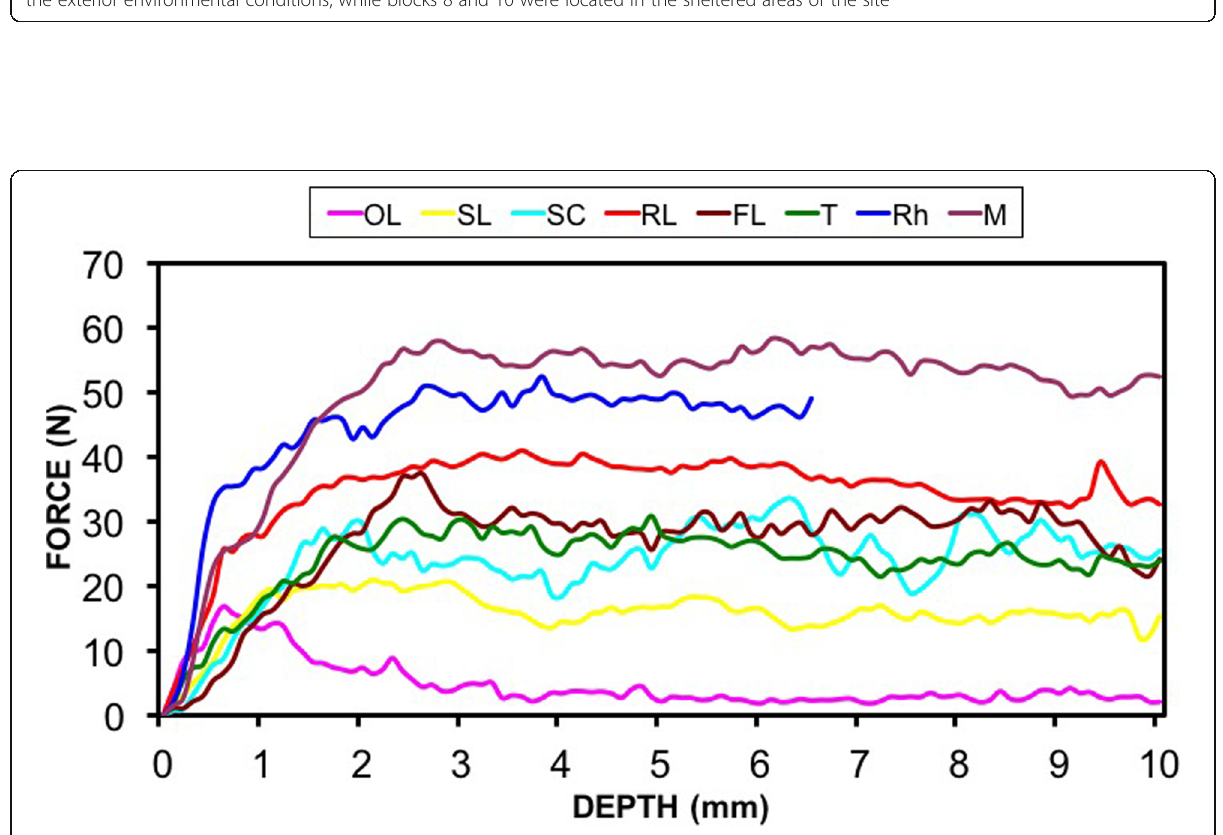
Fig. 8 Profiles of the different lithotypes measured in situ showing the average values of the demanded drilling forces versus the drilled depth from the surface to the interior of the material: oolitic limestone (OL), shelly limestone (SL), sandy calcarenite (SC), red limestone (RL), foraminifera- bearing limestone (FL), travertine (T), rhyolite (Rh) and marble